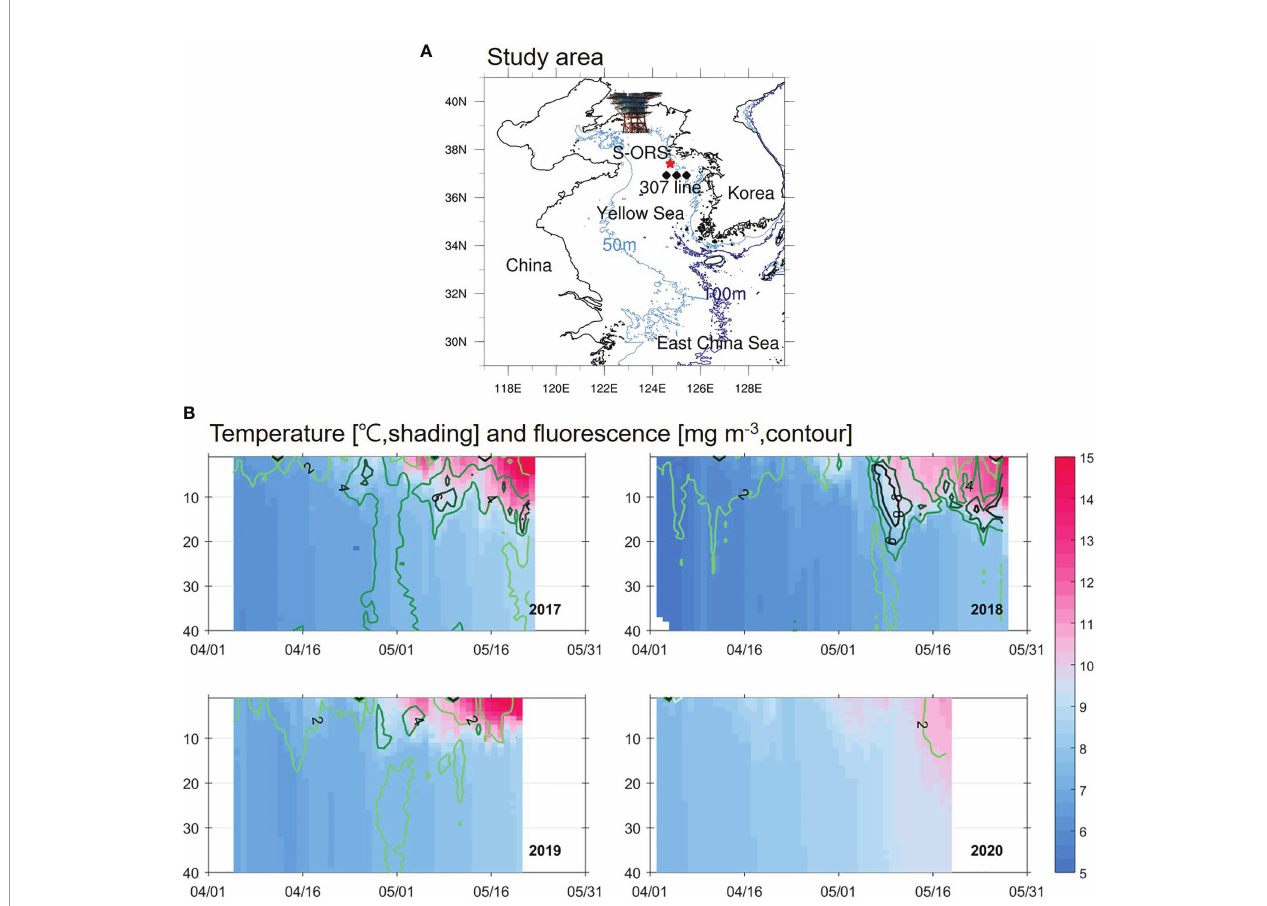
FIGURE 1 | (A) Map of the monitoring site used in this study: the Socheongcho Ocean Research Station (S-ORS; star marker), the nutrient observation stations on the 307 line from the Korea Oceanographic Data Center (diamonds) with a bathymetry of 50 and 100 m. (B) Time-depth diagram of temperature (°C, shading) and fl uorescence (mg m -3 , contour) during the spring of 2017 – 2020 from the S-ORS. The fl uorescence intervals are 2 mg m -3